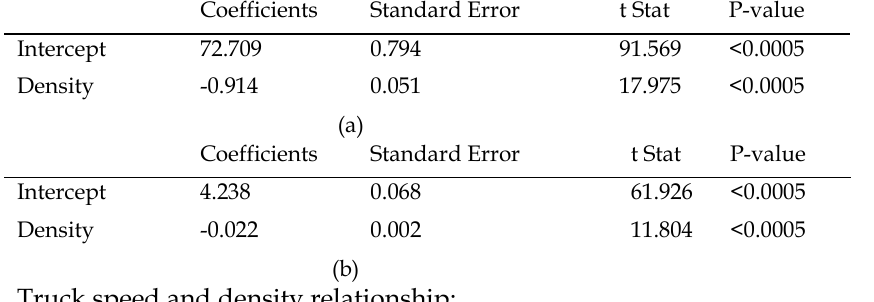
Table 5. (a) Case study I second cluster fitted results and (b) third cluster fitted